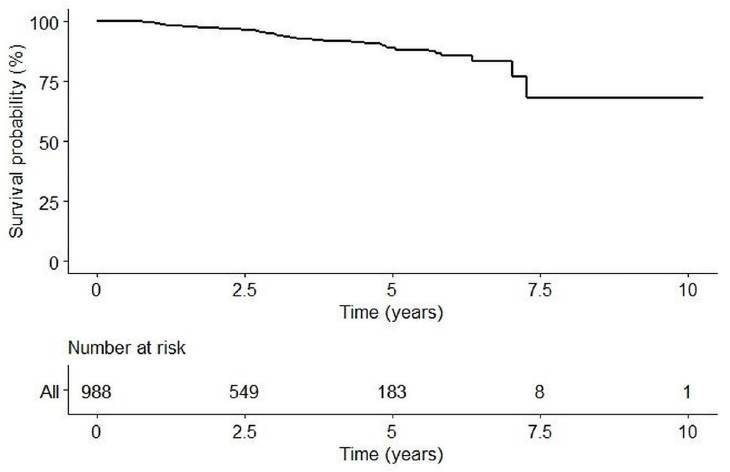
Fig 1. Overall survival curve.